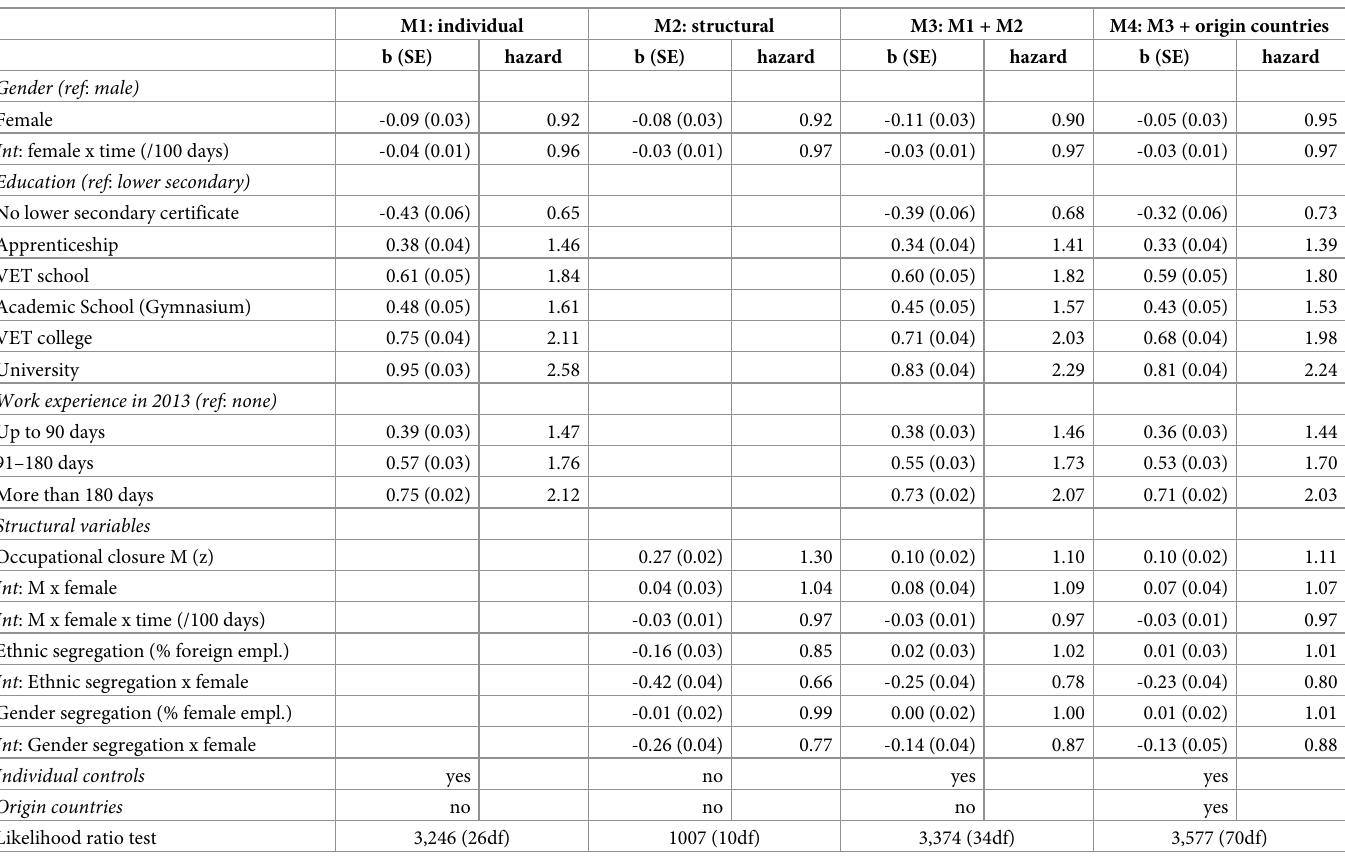
Table 1. Stratified cox proportional hazards, time to recurrent employment